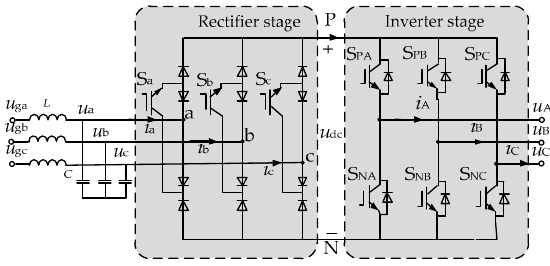
Figure 1. Typology of Ultra Sparse matrix converter.